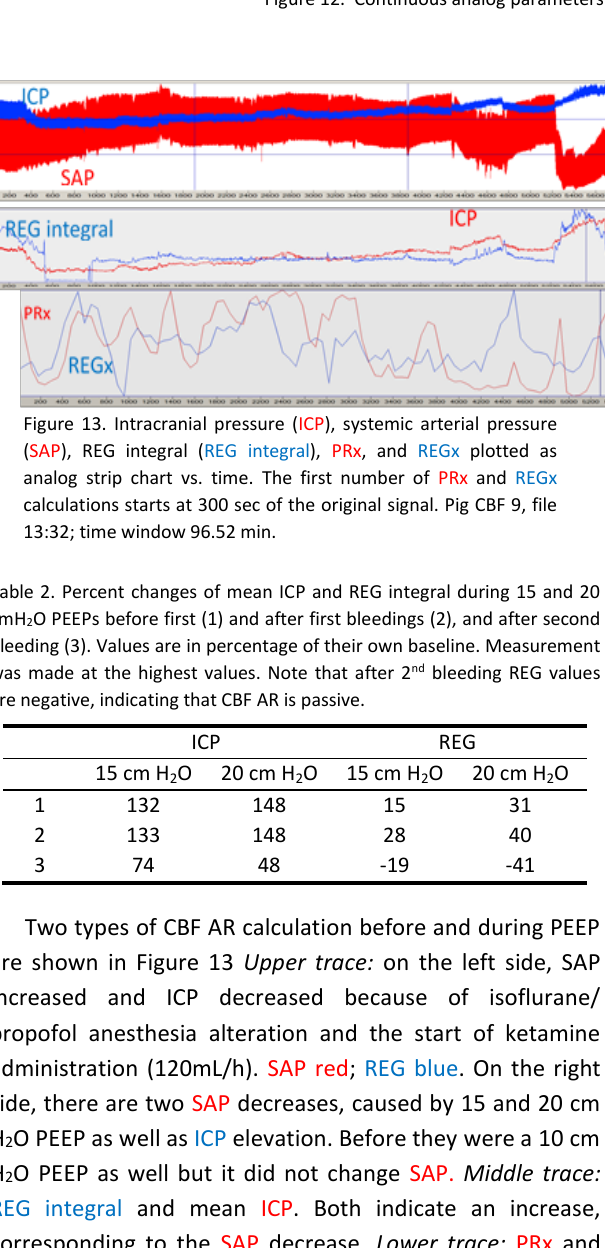
Figure 12. Continuous analog parameters (plotted as a strip chart) vs. time. CBF AR is passive.